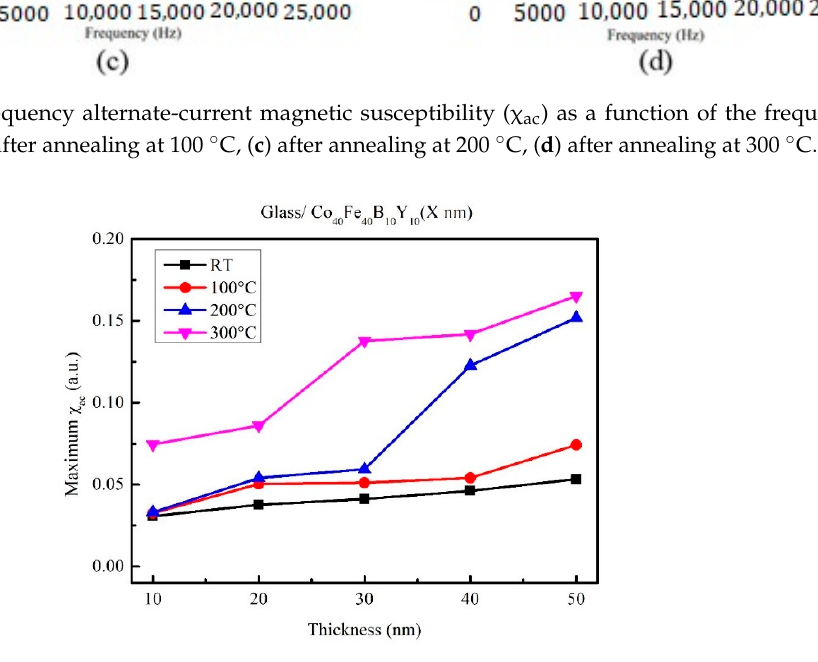
Figure 6. Maximum alternate-current magnetic susceptibility for the CoFeBY films. Table 2. Optimal resonance frequency for films of various thicknesses.